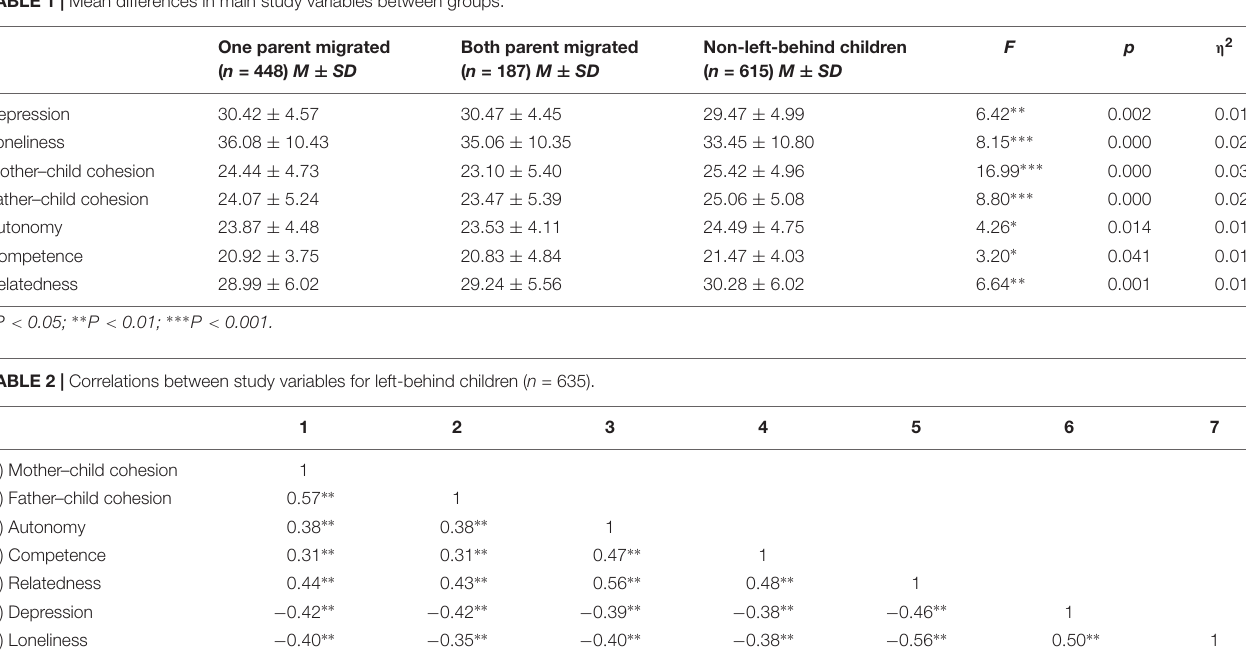
TABLE 1 | Mean differences in main study variables between groups.